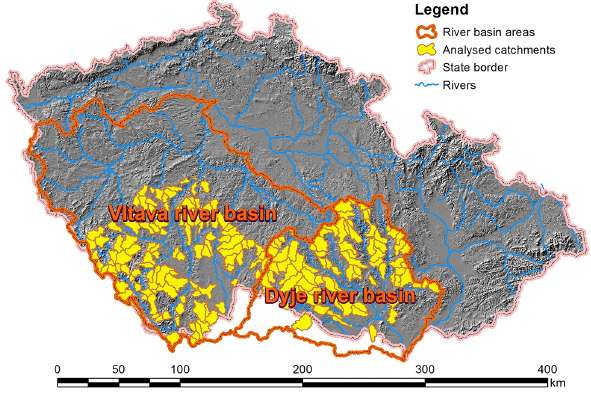
Figure 1. Catchments less than 150km 2 selected for the